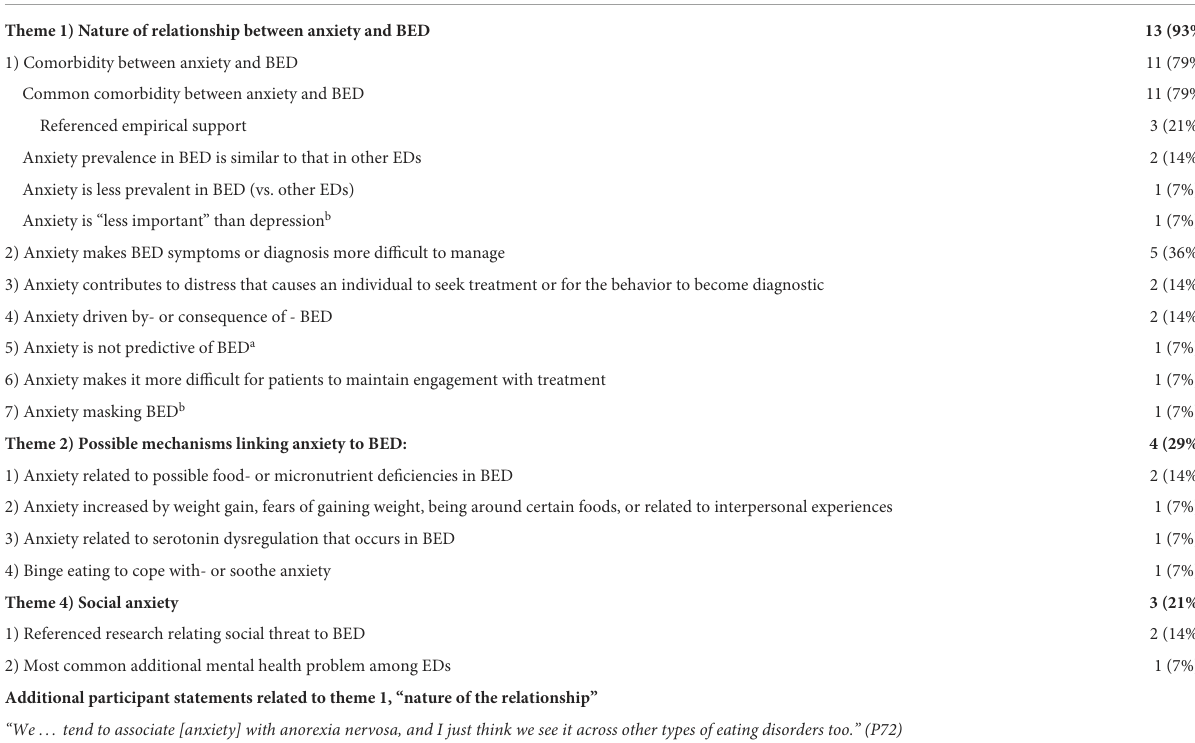
TABLE 5 Participant statements relating to domain 2, “anxiety”